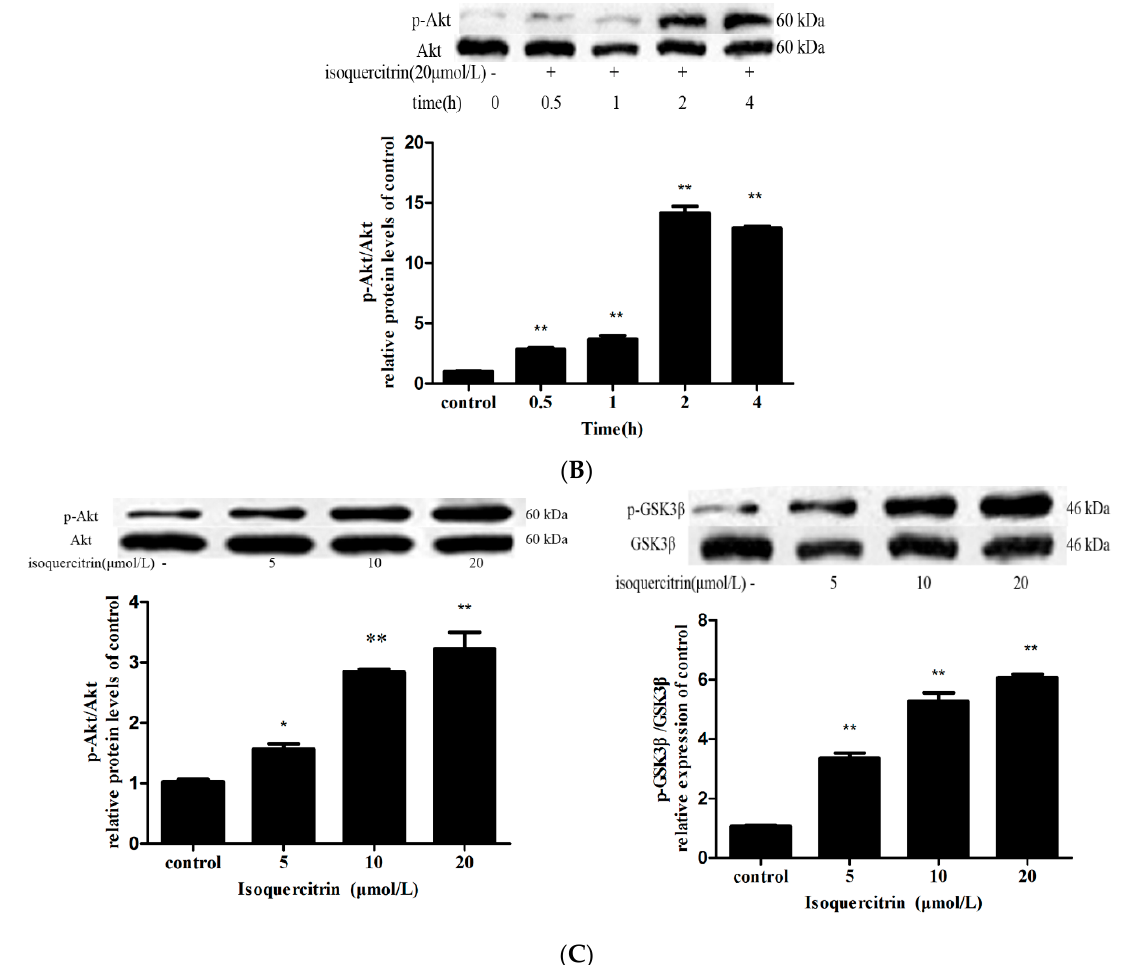
Figure 5. Effects of isoquercitrin on the expression of p-Akt, p-GSK3 β , and Mcl-1 in EA.hy926 cells. ( A ) Effects of LY294002 and SB216373 on the expression of p-GSK3 β , Mcl-1 and p-Akt in EA.hy926 cells. * p < 0.05, ** p < 0.01 vs. the control; ## p < 0.01 vs. isoquercitrin (20 µmol/L) group; ( B ) Effects of isoquercitrin (20 µmol/L) on the expression of p-Akt in EA.hy926 cells in different time, ** p < 0.01 vs. the control; ( C ) Effects of different concentrations of isoquercitrin on the expression of p-Akt, p-GSK3 β in EA.hy926 cells, ** p < 0.01 vs. the control.